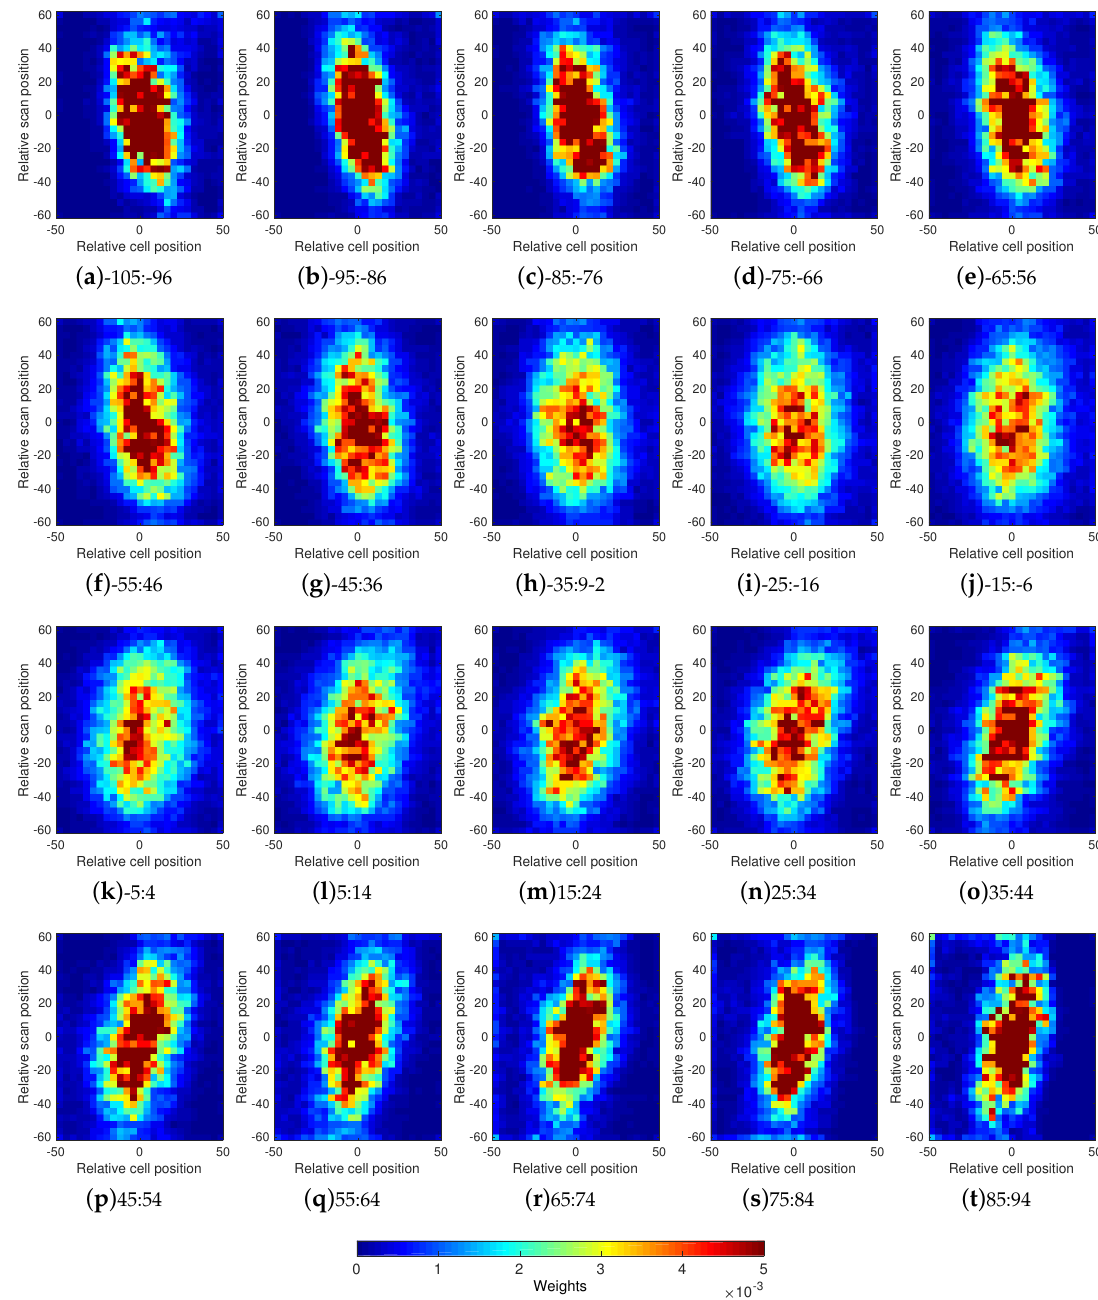
Figure 8. Estimated AMSR-E footprints determined from matchups over the AMSR-E cell range indicated in the sub-caption of each frame. The axes of each of the footprints are in units of MODIS pixels (no smoothing applied). First bin, − 115 to − 106, with relatively few matchups (Figure 7), is not